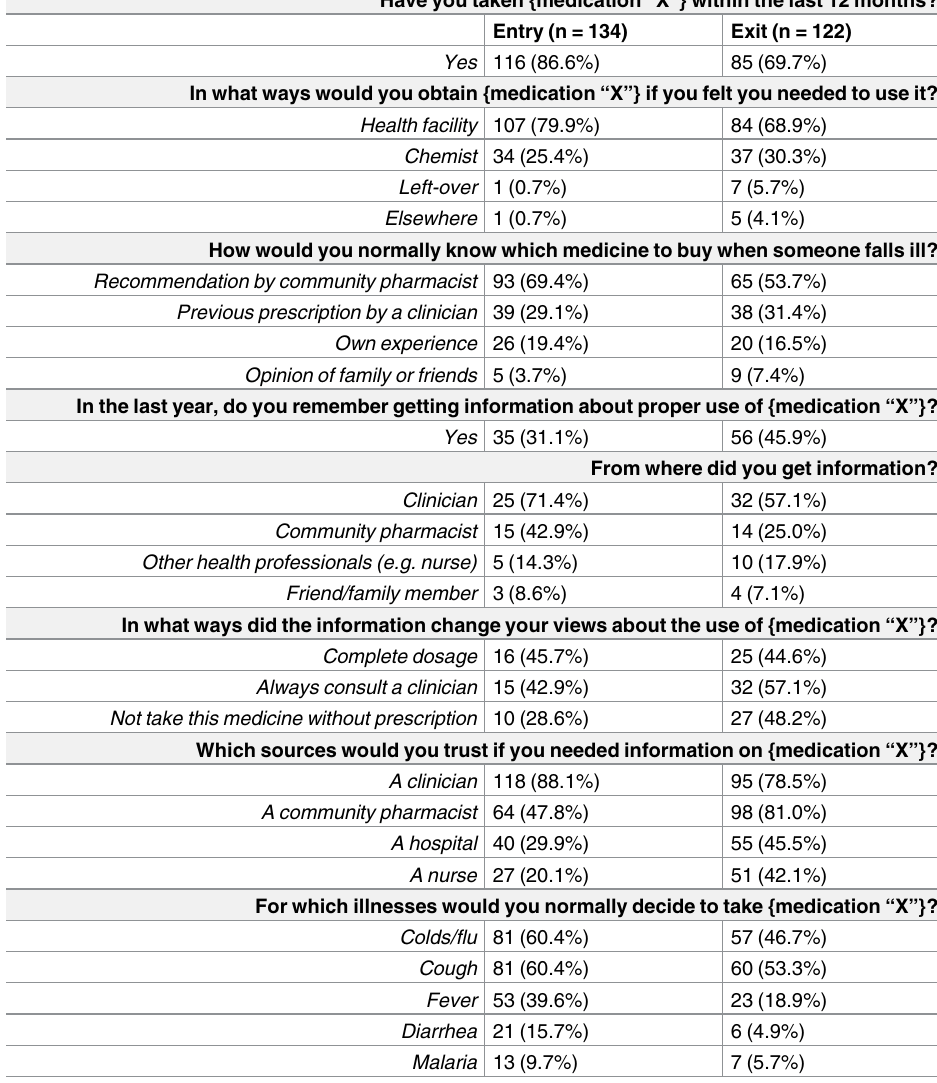
Table 2. Survey responses to questions regarding antibiotic use, sources of antibiotics and informa- tion on antibiotics. Have you taken {medication “X”} within the last 12